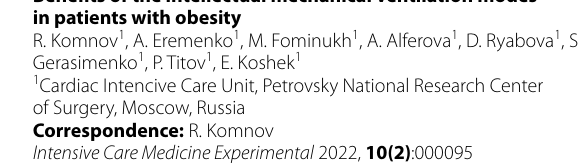
Figure 2. Conclusion: HFNC oxygenation was successful in 40.8% of patients with severe SARS-CoV2 pneumonia saving 28 patients from IMV